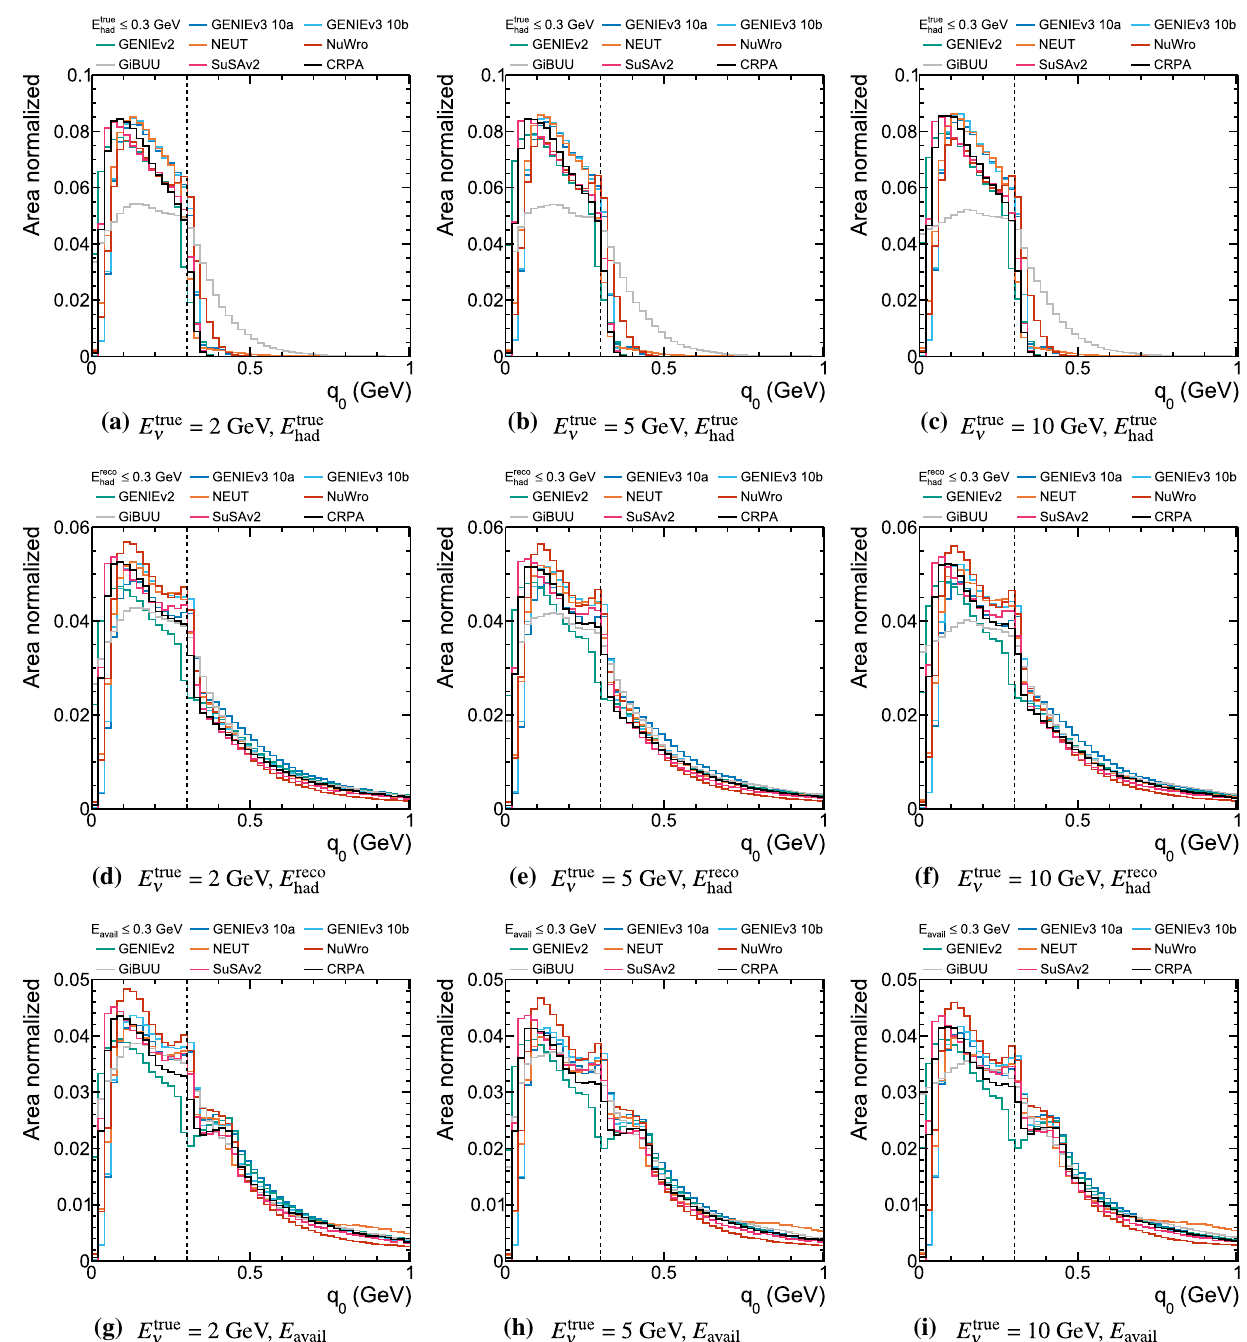
Fig. 6 The q 0 distributions for CC-inclusive ν μ – 40 Ar events which pass cuts on the three proxy variables which are experimentally observ- able: E true , E reco and E avail ≤ 0.3 GeV, shown for all the generators had had